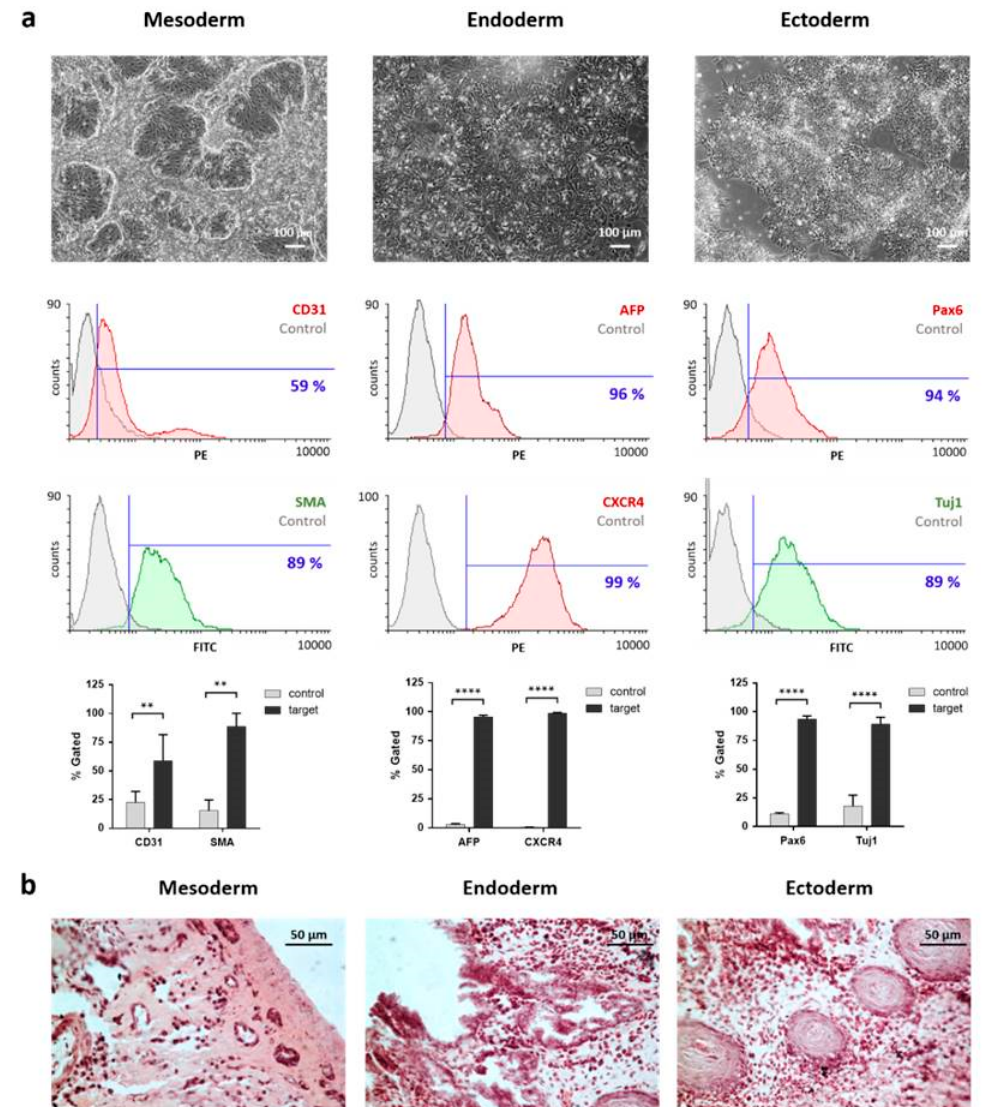
Figure 4. Trilineage differentiation potential of JPC-derived iPSCs. ( a ) Microscopic pictures of mesodermal, endodermal and ectodermal in vitro differentiation showing different morphologies after six days of germ layer specific differentiation. Flow cytometry analysis of differentiated cells was performed after staining with specific antibodies compared to untreated controls. Data are shown as mean + SD. Differences were compared using one-way ANOVA ( n = 3, ** p < 0.01, **** p < 0.0001). ( b ) Microscopic images of in vivo teratoma formation of iPSCs using a chorioallantoic membrane (CAM) assay. H&E stained sections showed mesodermal (bone-like), endodermal (gut-like) and ectodermal (squamous epithelium) tissue.